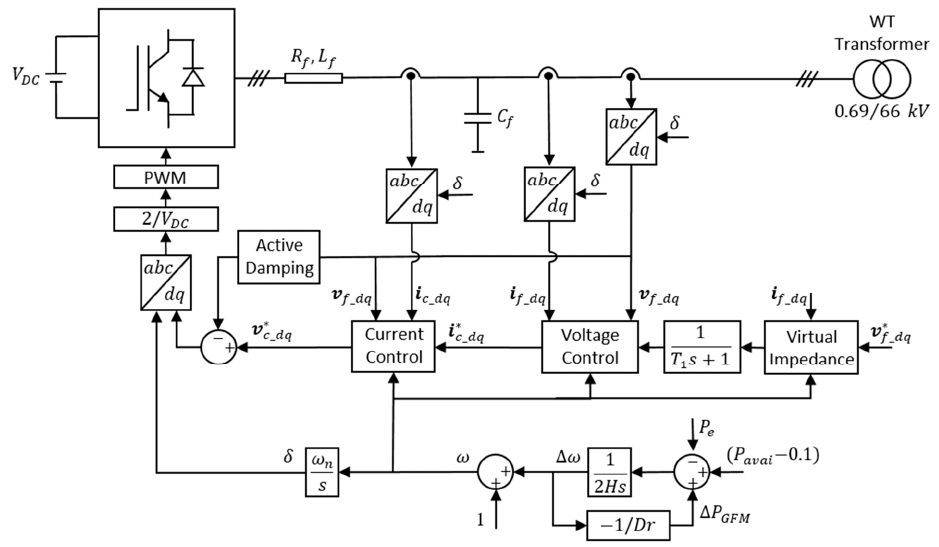
Figure 4. The GSC control scheme with the GFM-FCM.